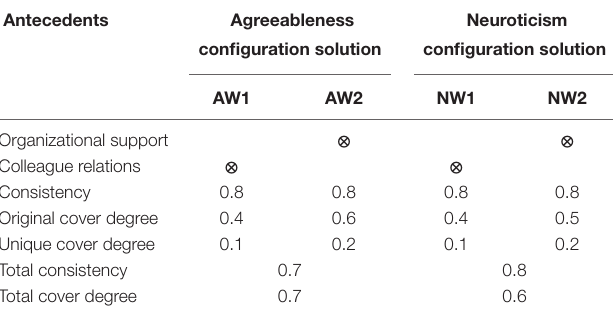
TABLE 10 | Matching analysis of work experience and non-high original innovation